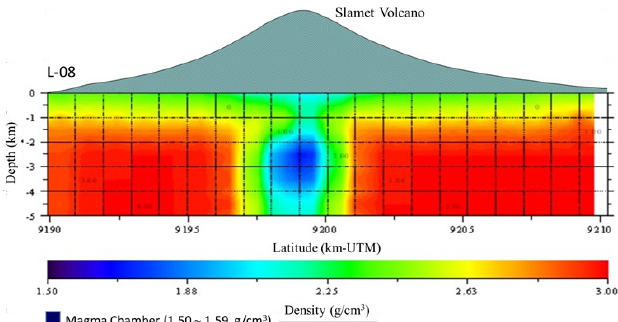
Fig. 17. A cross-section of the anomalous object model along L-08 trajectory at longitude of 304.550